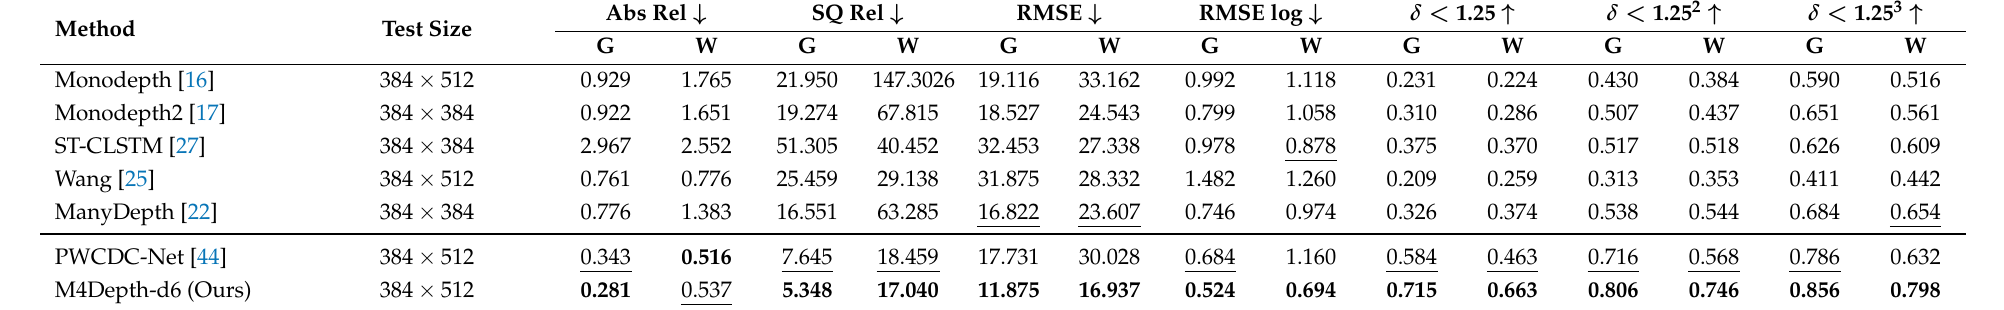
Table 4. Performance for the generalization test on two unstructured environments from TartanAir, that are gascola (G) and season forest winter (W). Scores were generated by using the same network weights as the ones used to report the performance on Mid-Air in Table 2. The best score for a metric is highlighted in bold and the second best is underlined. The four first metrics need to be minimized ( ↓ ) and the three last ones need to be maximized ( ↑ ).